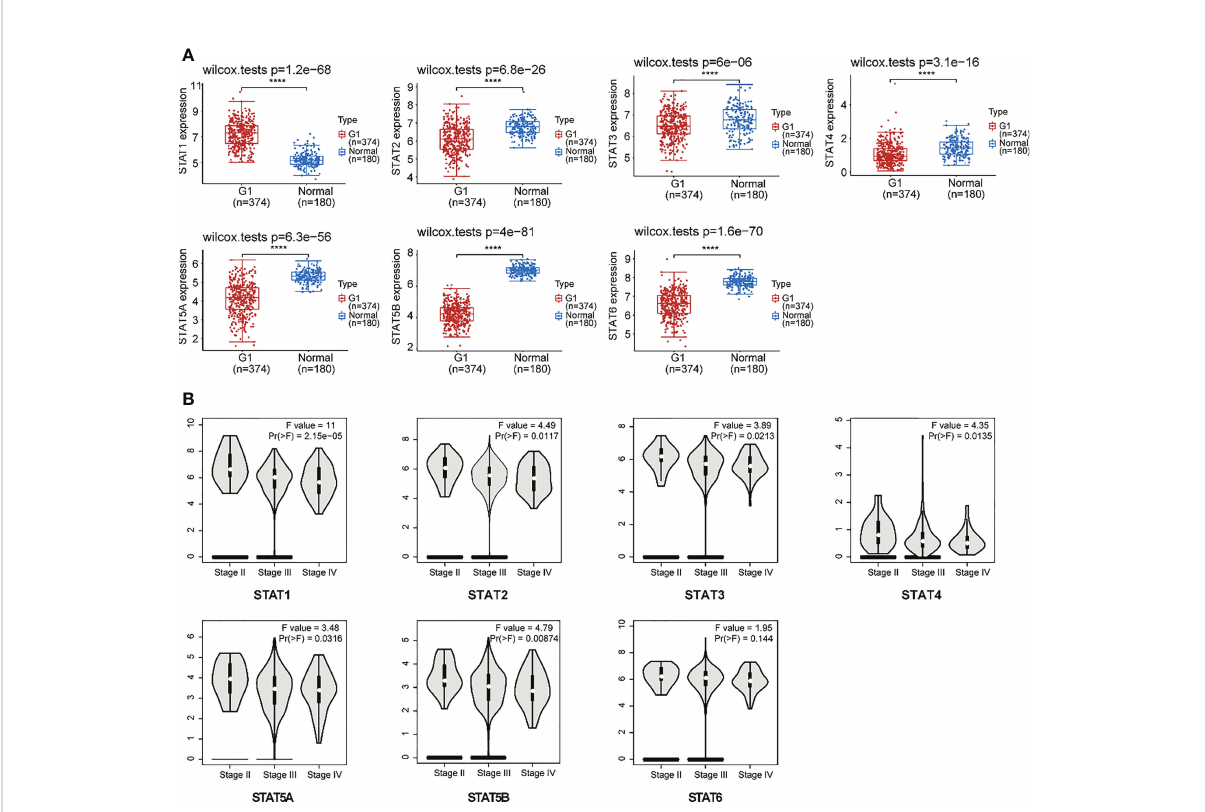
FIGURE 3 Expression of STAT family members in ovarian cancer. (A) The expression distribution of STAT family genes in ovarian cancer tissues (G) and normal tissues. Top-left represented the signi fi cance P -value, **** P < 0.0001. (B) An association between STATs expression and major tumor stages in patients with ovarian